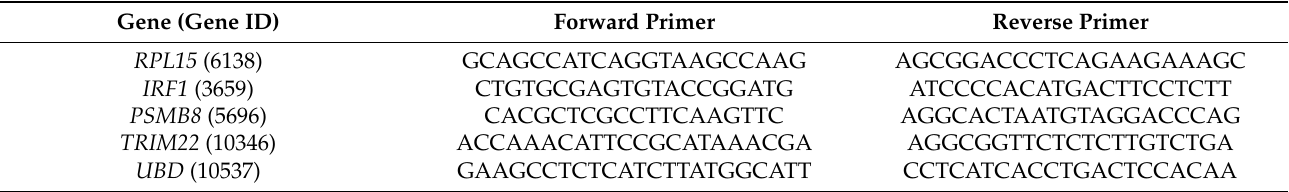
Table 1. Sequence of primer pairs employed for RT-qPCR